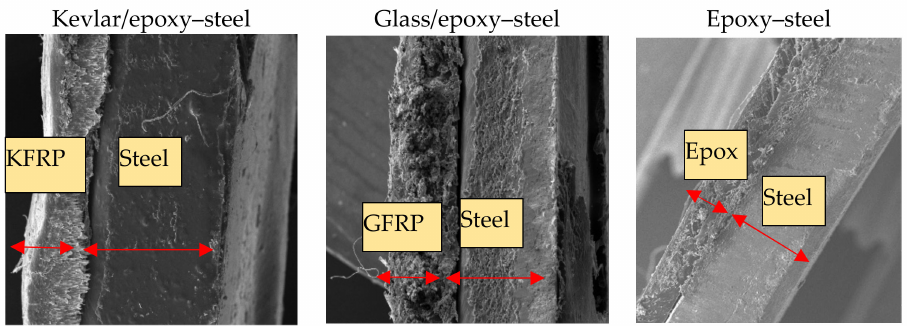
Figure 2. Cross-sectional SEM images of the prepared